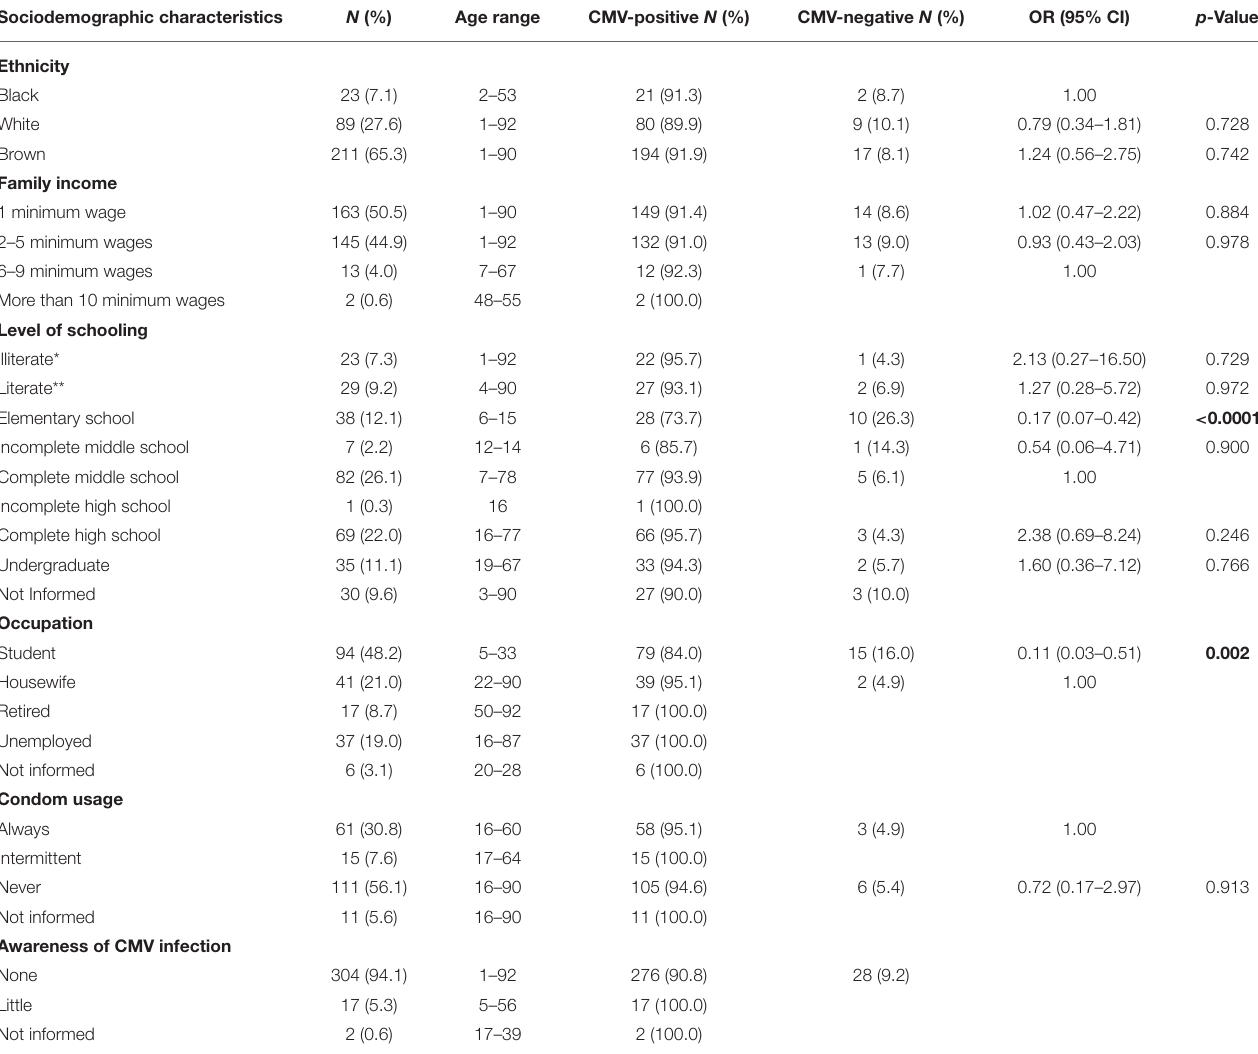
TABLE 3 | Prevalence rates of CMV infection according to sociodemographic characteristics of the study population. Sociodemographic